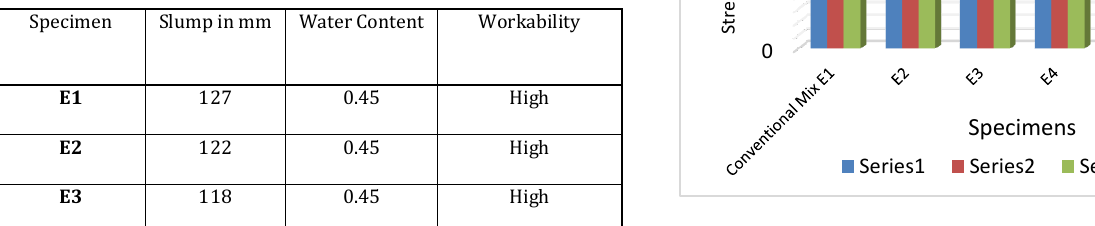
Figure 2: Compressive Strength